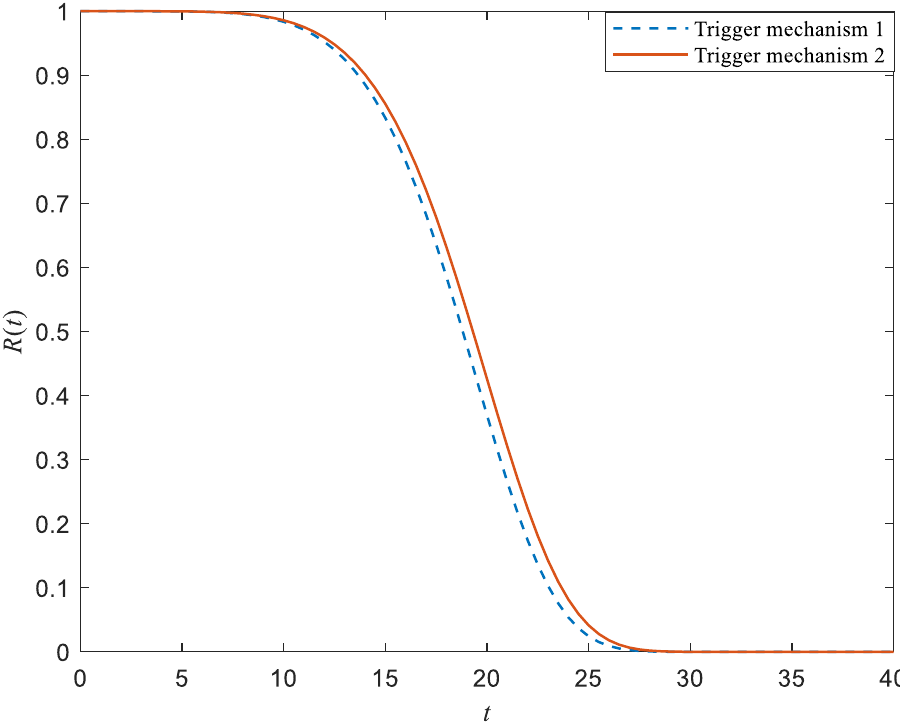
Figure 6. The comparison of different trigger mechanisms.